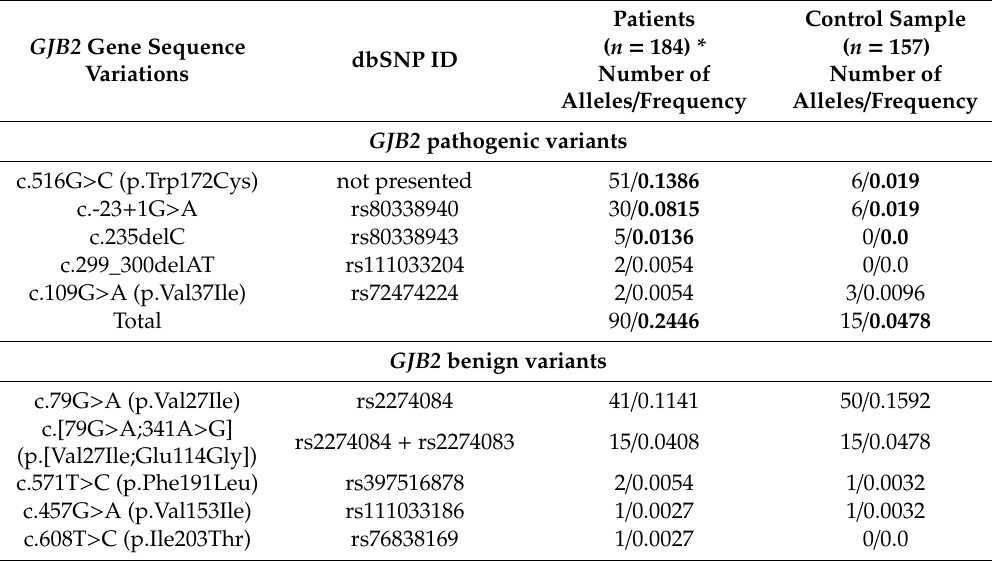
Figure 2. The pedigrees of Tuvinian families demonstrating the segregation of variant c.516G > C (p.Trp172Cys) in a homozygous state or in compound with other recessive GJB2 mutations (c.235delC, c.-23 + 1G > A, and c.299_300delAT) with HL in a ff ected family members. Deaf individuals are shown by black symbols. The variant c.516G > C (p.Trp172Cys) is shown by red. Table 3. Frequencies of the GJB2 gene variations in Tuvinian patients and the control